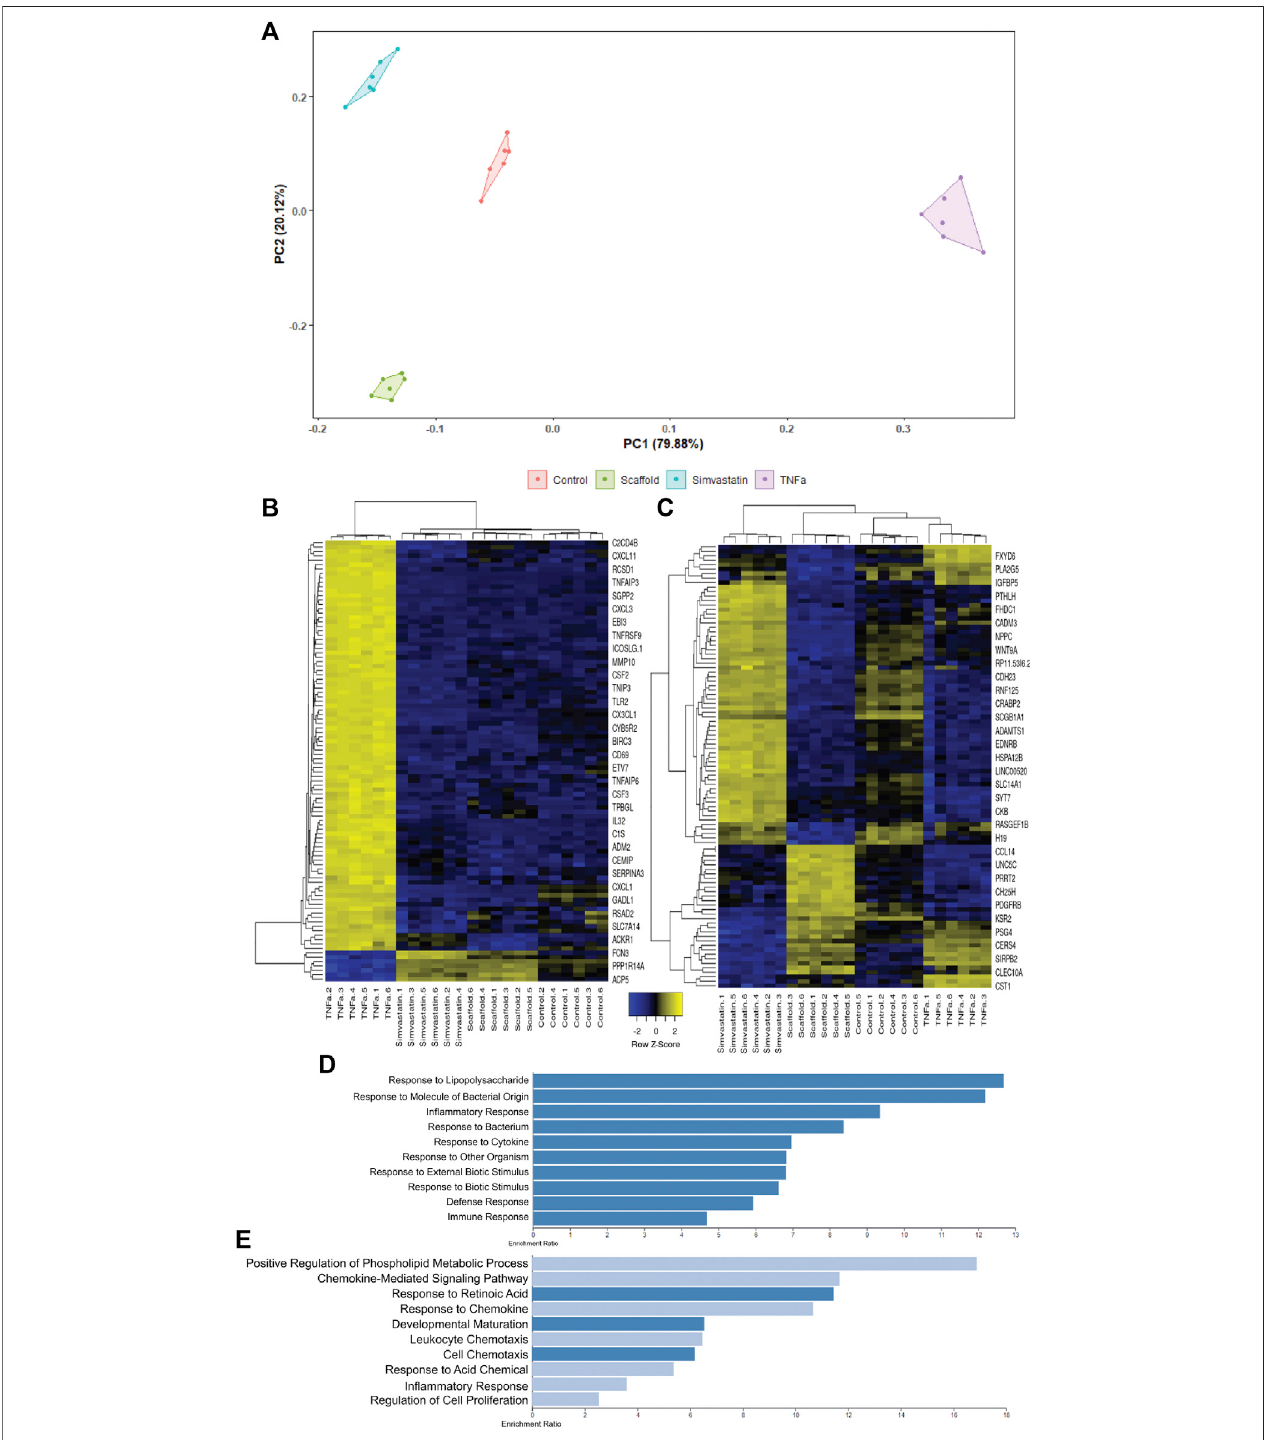
FIGURE5| tSNEclusteringanalysisofscaffoldseeded,simvastatin,andTNF α -treatedhAECs.ThetSNEclusteringanalysisplotisdrivenbythetop1,000variable genesacrossallsamples (A) .PC1accountsfor79.88%ofthevariance,whilePC2explainstheremaining20.22%.Heatmapofthetop100genesresponsiblefordriving PC1 (B) .PC1isalmostexclusivelydrivenbyup-regulatedgenesintheTNF α group.Enrichmentplotofthetop10enrichedgeneontologybiologicalprocessesforthetop 100 genes driving PC1 (D) . The top 10 enriched pathways in PC1 are all associated with pro-in fl ammatory responses. Heatmap of the top 100 genes responsible fordrivingPC2 (C) .PC2ispredominantlydrivenbyup-regulatedgenesinthescaffoldgroup.Enrichmentplotofthetop10enriched geneontologybiologicalprocesses for the top 100 genes driving PC2 (E) . 50% of the enriched pathways in PC2 are associated with cellular chemotaxis and respond to chemokines.